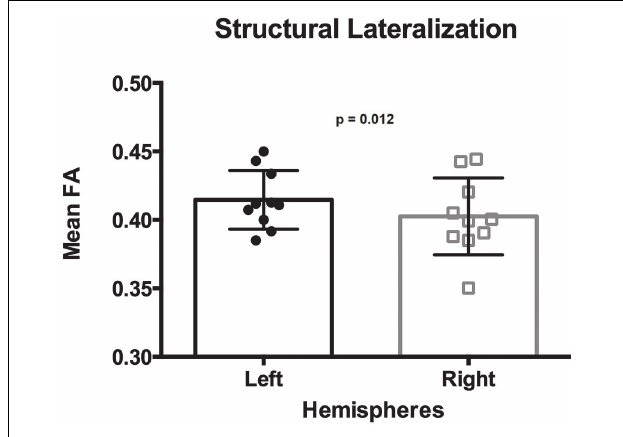
FIGURE 5 | Lateralization of the ILF determined by the mean FA. Each dot and square represents one individual mean FA value. Error bars represent standard deviation. The mean FA of the left ILF is significantly higher than that from the right ILF ( p = 0.012).